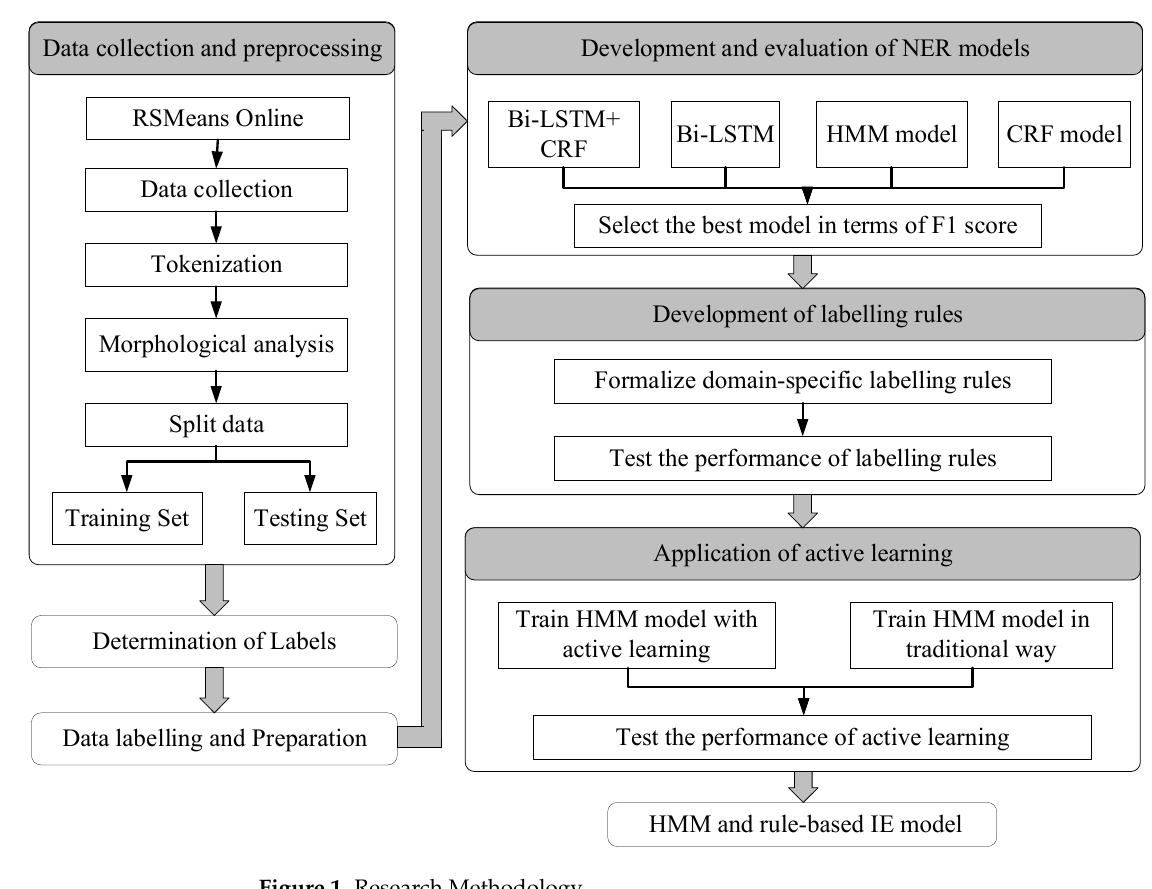
Figure 1. Research Methodology.